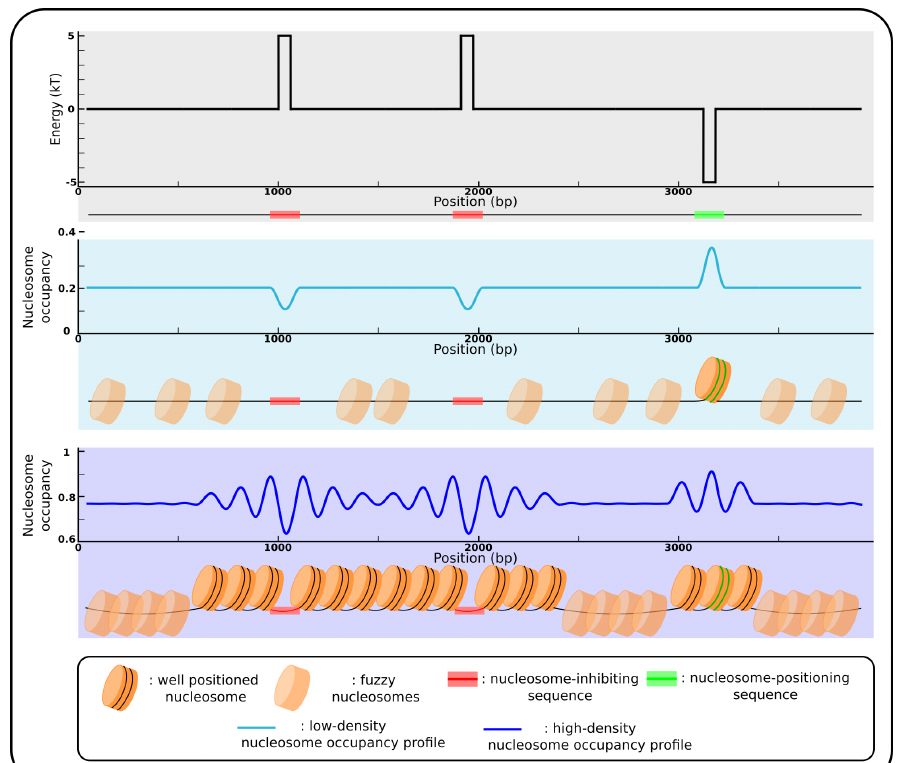
Figure 1. Nucleosomal positioning by sequence motifs. ( Top panel) Landscape of the energy needed to bend the DNA fragment into the nucleosome depending on the sequence around the nucleosome dyad position ( x -axis); the hypothetical landscape present two high energy peaks corresponding to two nucleosome-inhibiting sequence motifs (red), and a low energy well at a nucleosome-positioning sequence motif (green). (Mid panel) Nucleosome occupancy profile corresponding to the energy landscape for a low density of nucleosomes. Nucleosomes tend to avoid the inhibiting sequences (as represented by the minima in sky blue curve), and the only preferential nucleosome localisation is at the positioning sequence (peak in sky blue curve). ( Bottom panel) Nucleosome occupancy profile to corresponding the energy landscape for a high nucleosome density. In this case, nucleosomes still avoid inhibiting sequences (minima in the blue curve), and a global positioning appears between and beside these nucleosomal barriers (oscillations in the blue curve), as a “parking” phenomenon resulting from the non overlapping property of nucleosomes (statistical positioning) (see Section